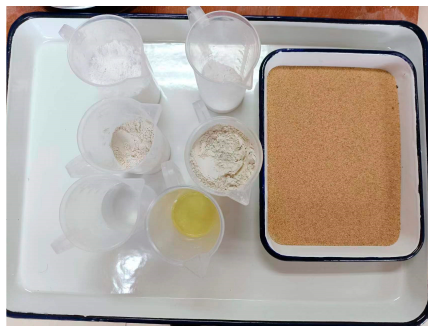
Figure 10. Model test section.